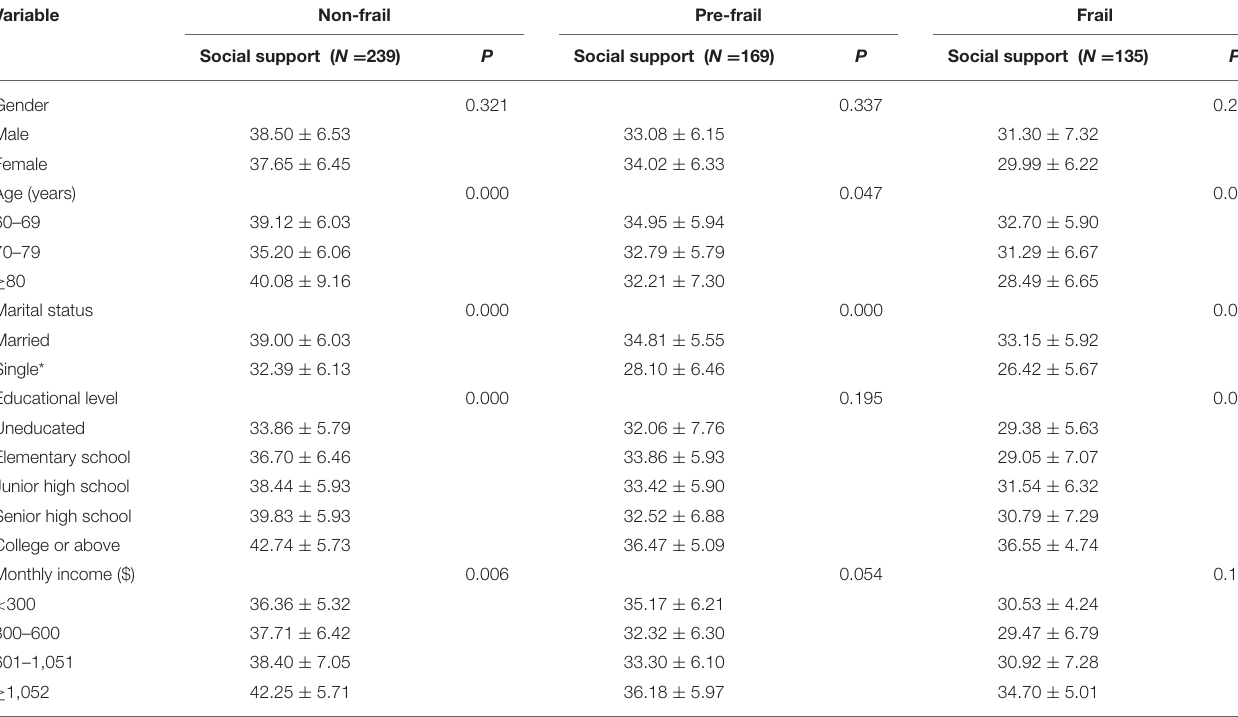
TABLE 3 | The impact of demographic characteristics on social support according to the frailty category.